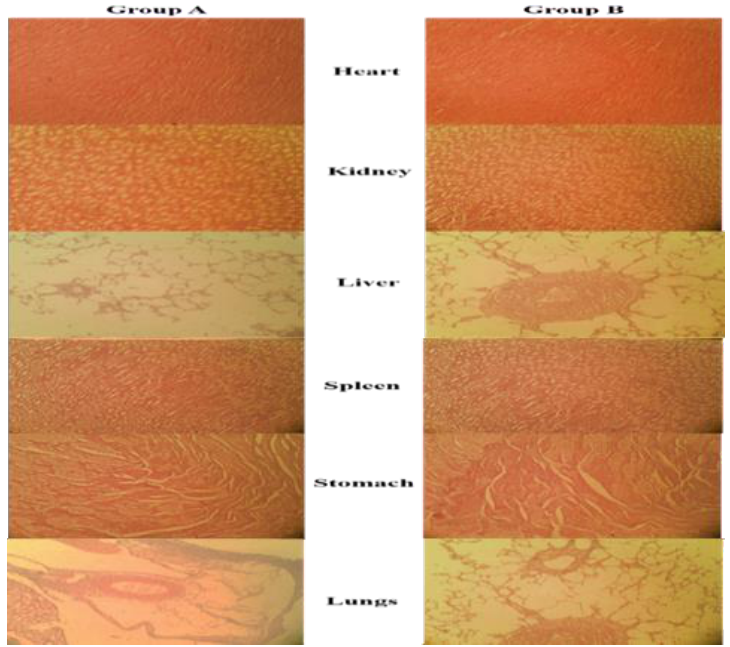
Figure 7. Histopathological examination of the control group (Group A ) and treated group (Group B ).